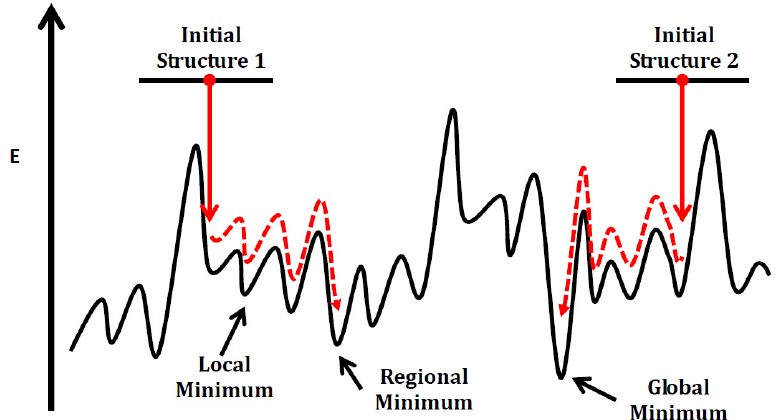
Figure 10. Illustrative diagram for Si dashed lines indicate the paths of searching a regional minimum from a random-generated initial